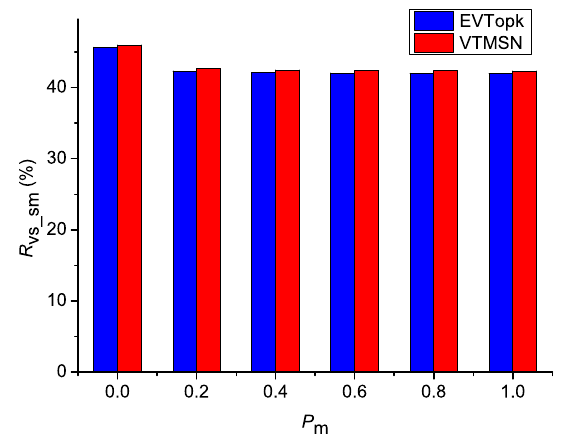
Figure 4. C sm with different settings of P m .